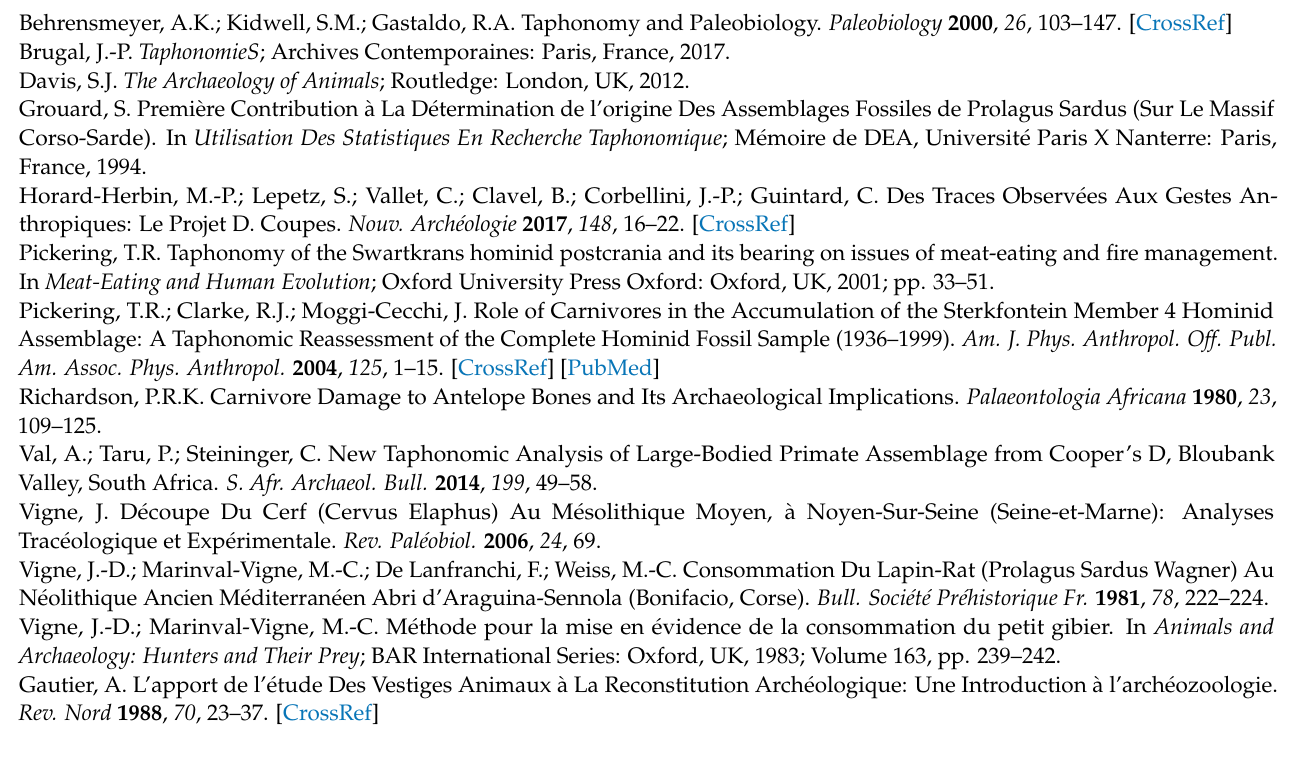
Table S2: Number of identified specimens (NISP) of Oryzomyini and Dasyprocta ; Table S3: Description of the 13 landmarks digitalized; Table S4: Description of the most common fragmentation patterns for Oryzomyini and Dasyprocta ; Table S5: Oryzomyini most frequent patterns tested according to the three